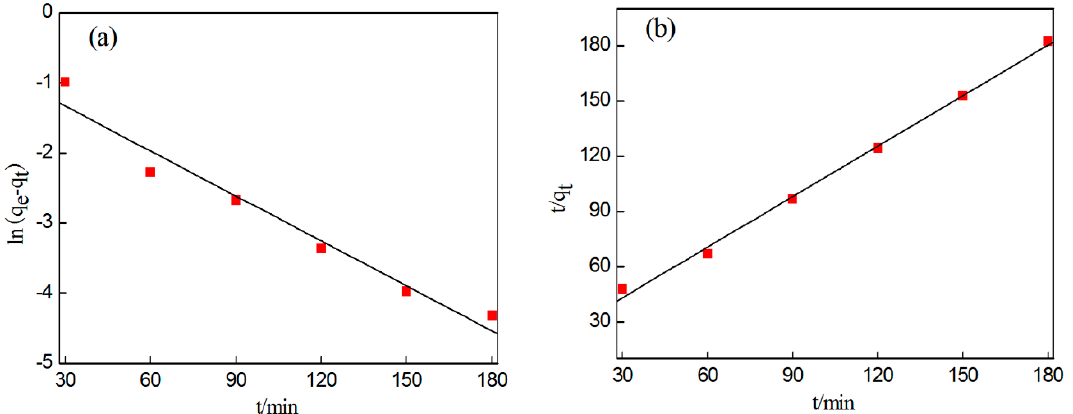
Figure 10. Fitting of kinetic models. ( a ) First-order kinetic model. ( b ) Second-order kinetic model. Table 6. Fitting parameters of kinetic models ( q e : the gold deposit amount (mg) at equilibrium time; k 1 : the deposition rate of model ( a ); k 2 : the deposition rate of model ( b ); R 2 : correlation coefficient).